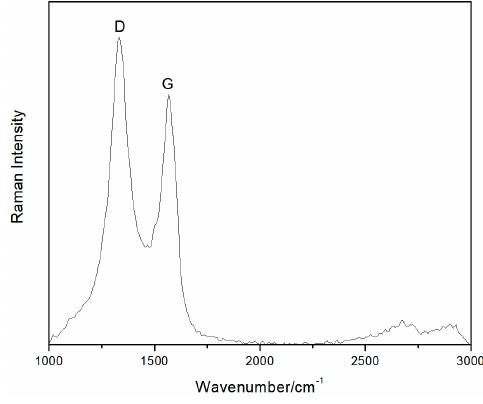
Figure 3. Raman spectra of the rGO membrane.